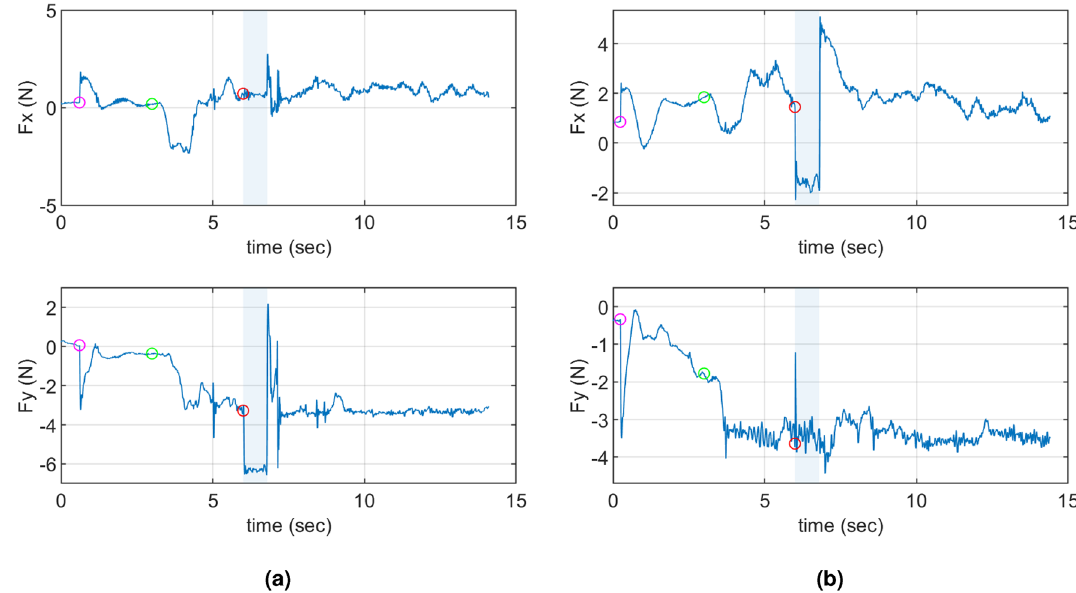
Figure 2. The interaction forces during the entire duration of two representative trials of subject 1. Pink marker: the instant when the position-based background stiffness controller was activated. Green marker: the instant when the robot started moving and the subject began walking with the robot. Red marker: the instant when the force perturbation was initiated; the blue shaded region shows the 800 ms duration of the perturbation. The earlier portion of this 800 ms window is used for arm stiffness estimation. ( a ) is the representative lateral (- y ) perturbation and ( b ) is the representative forward (- x ) perturbation.